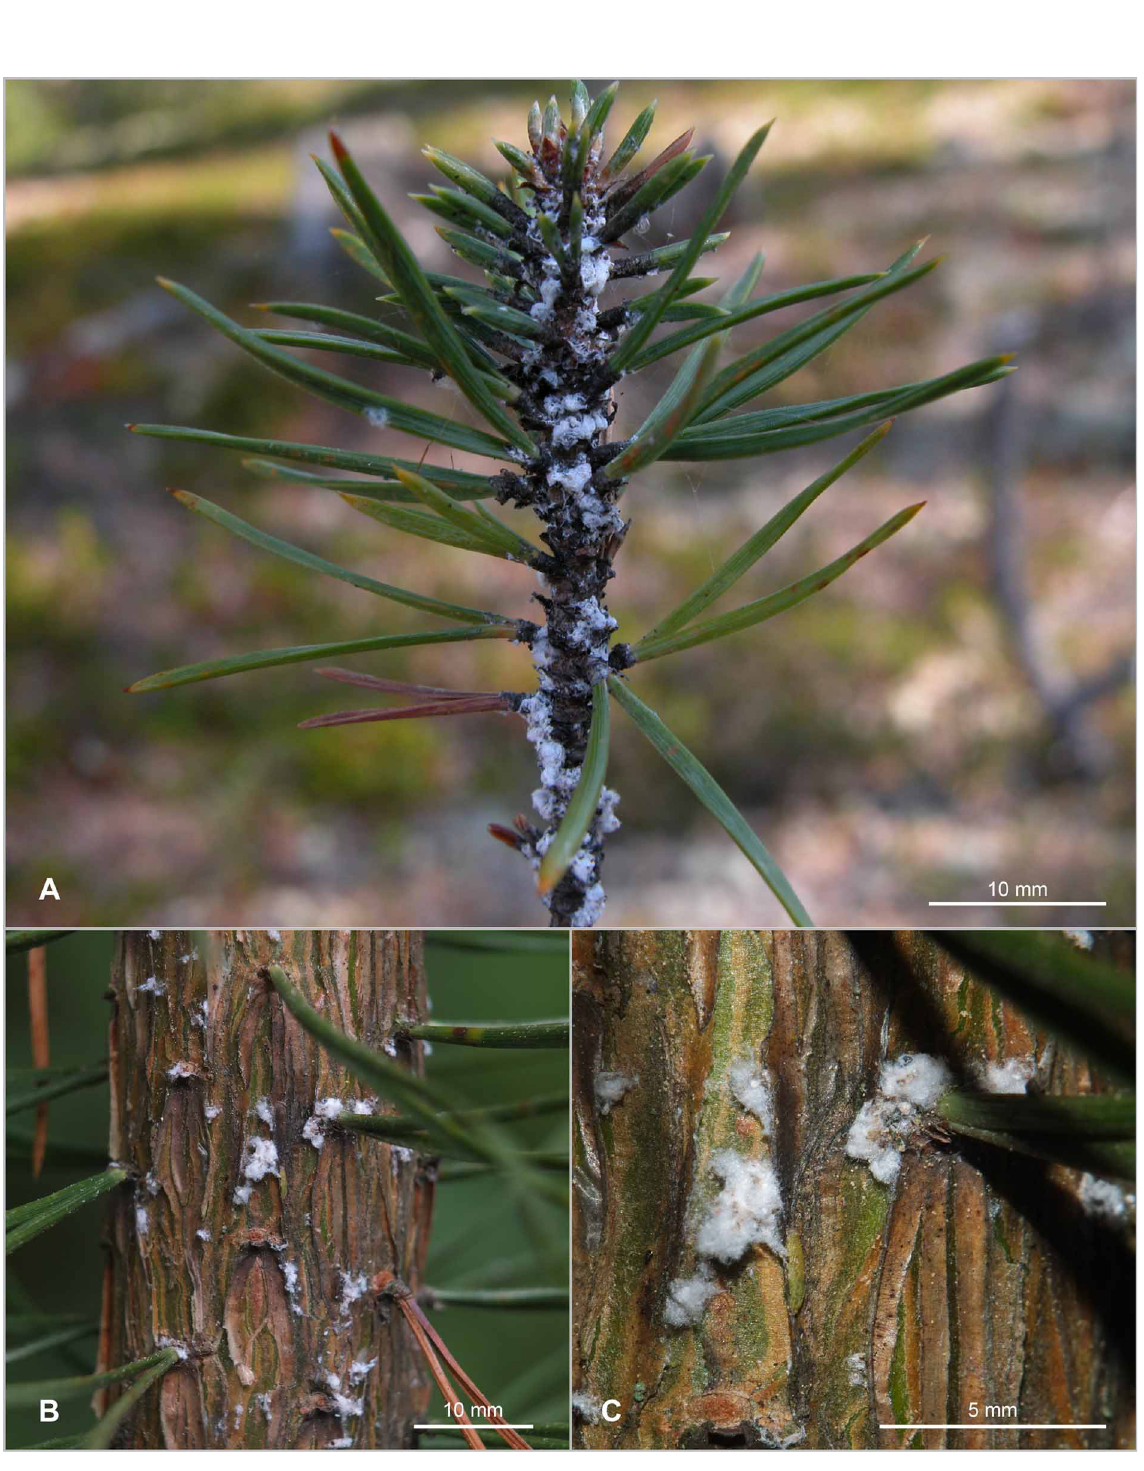
Fig. 72. Pineus (Pineus) pini (Macquart, 1819) on Pinus sylvestris . A . Old colony on dwarfish pine. B – C . Apterae on trunk of young